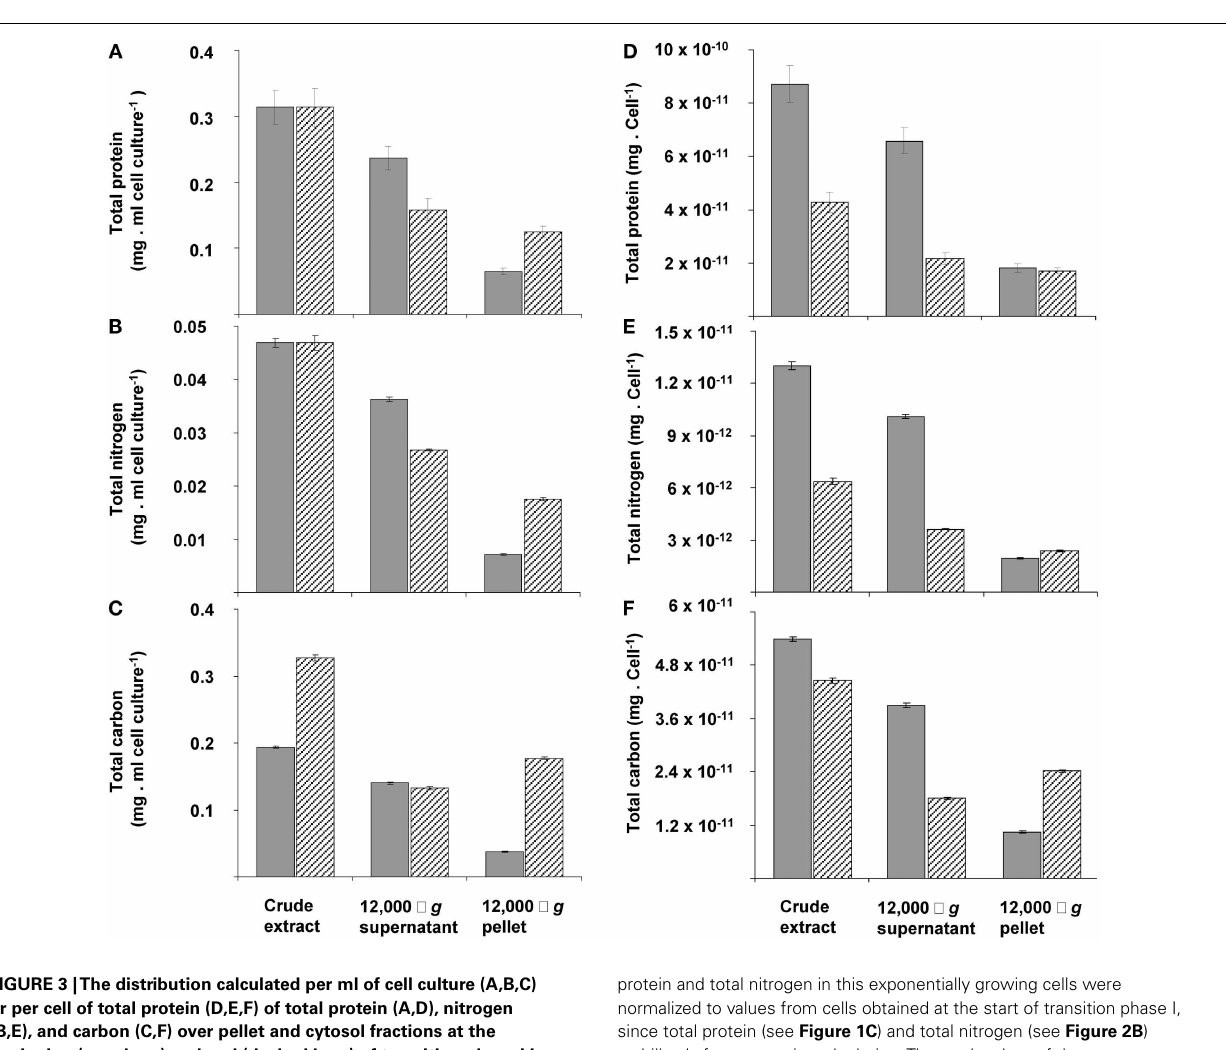
FIGURE 3 |The distribution calculated per ml of cell culture (A,B,C) or per cell of total protein (D,E,F) of total protein (A,D), nitrogen (B,E), and carbon (C,F) over pellet and cytosol fractions at the beginning (gray bars) and end (dashed bars) of transition phase I in the crude extract, 12,000 × g supernatant and 12,000 × g pellet. This experiment was performed with exponentially growing cells that had reached an optical density of 0.5 (see Figure 2A ).The amount of total